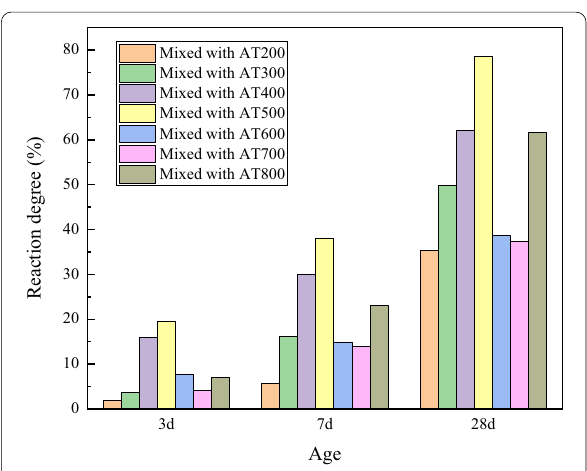
Fig. 8 Compressive strength of attapulgite mortar.